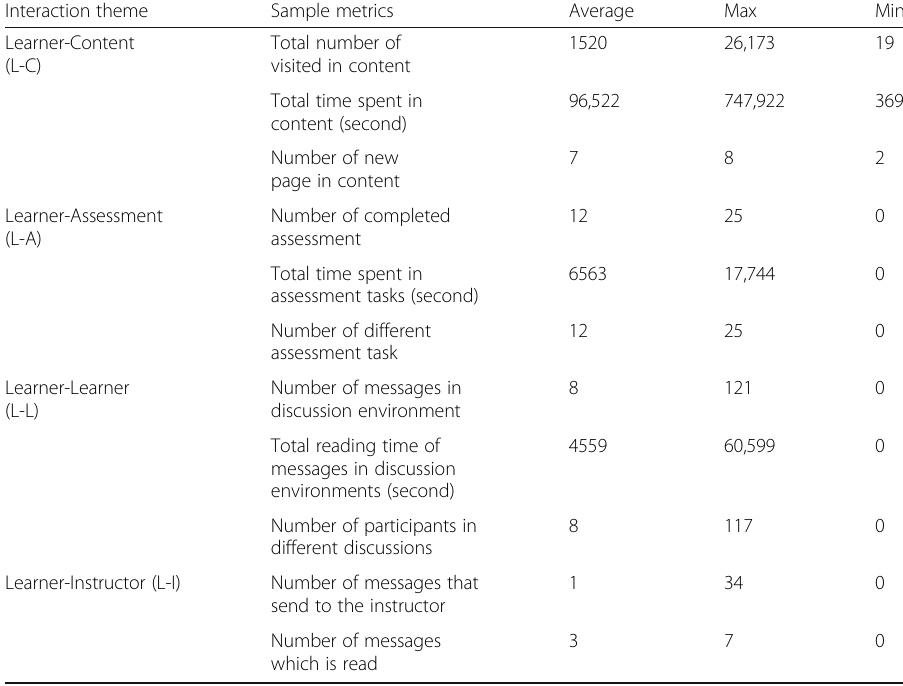
Table 5 Descriptive information about the system interaction Interaction theme Sample